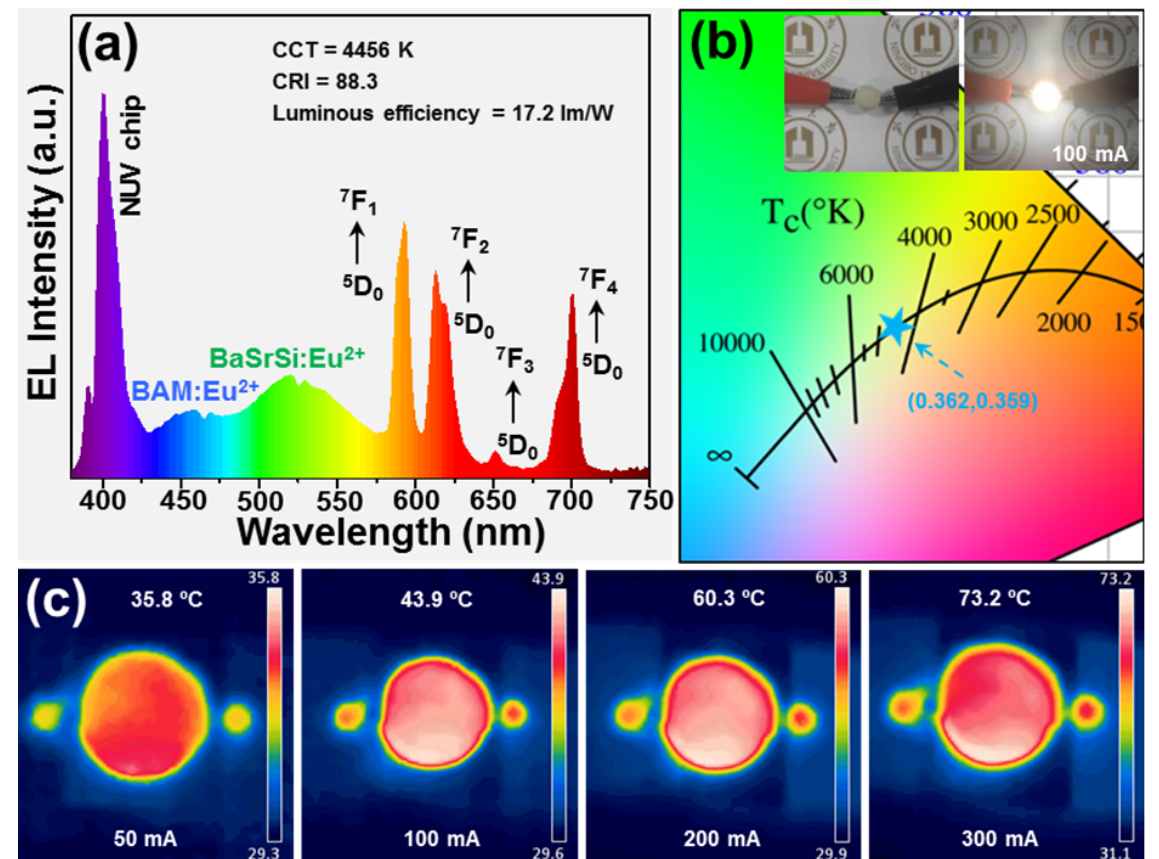
Figure 5. ( a ) EL emission profile and ( b ) CIE chromaticity diagram of packaged white-LED under the injection current of 100 mA. Inset of ( b ) displays the optical graphs of developed white-LED. ( c ) Thermal photos of packaged white-LED at various driven currents.